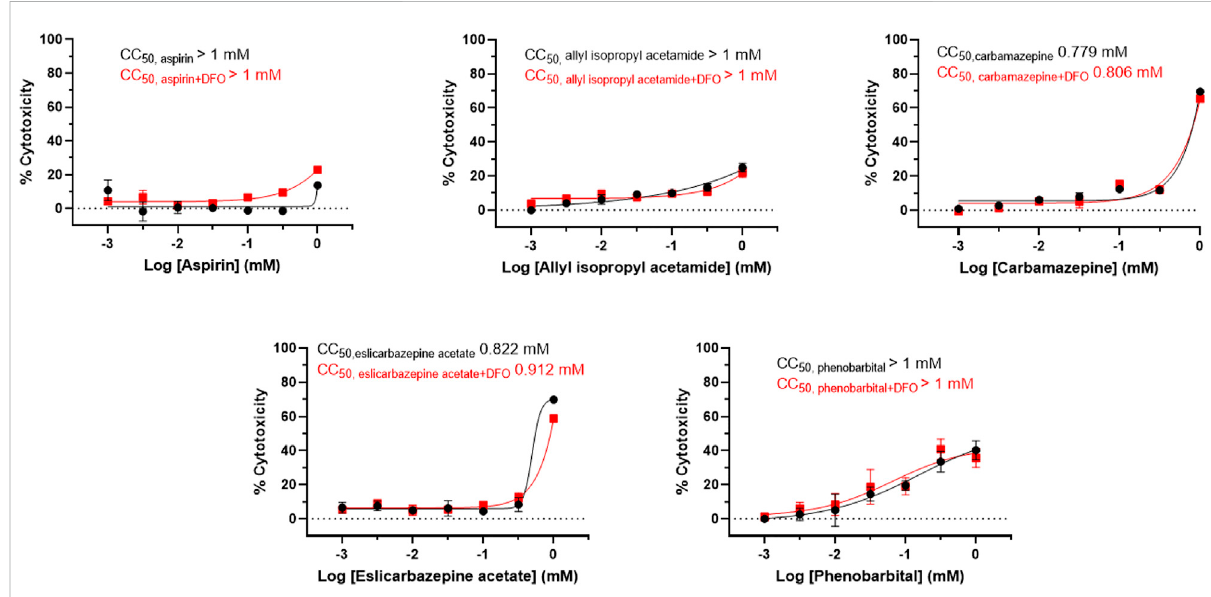
FIGURE 2 Cytotoxicity of eslicarbazepine acetate and other compounds in LMH cells. The ATPLite cytotoxicity assay was completed in parallel with the drug screening assays. CC 50 values were calculated using the software, GraphPad Prism 8. All data are presented as mean values ± SEM of three independent replicates. All results are representative of three independent